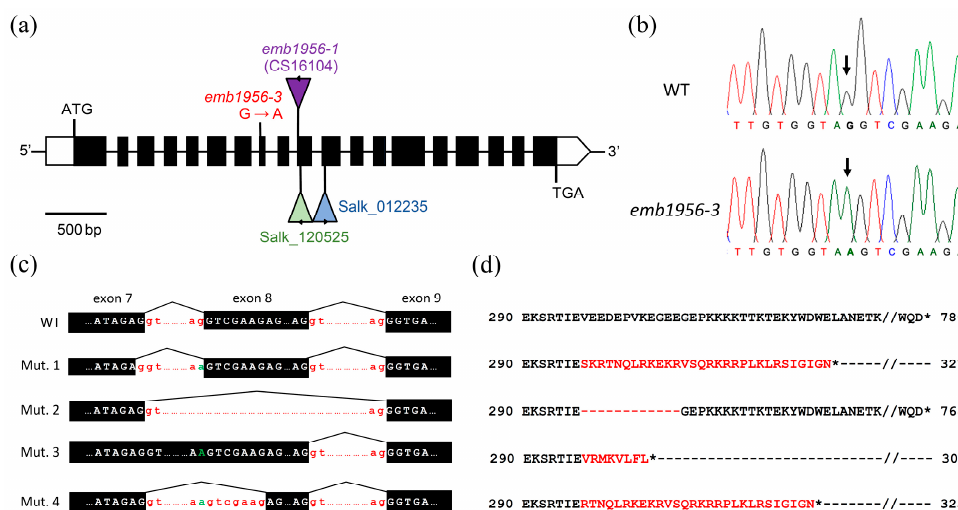
Figure 3. Structure of the At2g04030 gene and effects of the emb1956-3 mutation described in this work. ( a ) Intron–exon structure of the gene. The black rectangles represent the coding sequences. The 5 ′ and 3 ′ untranslated regions (UTRs) are indicated in white. The positions of the insertions and the point mutation are indicated on the scheme. ( b ) G-to-A transition mutation of the emb1956-3 allele (marked by an arrow), as detected via Sanger sequencing. ( c ) The emb1956-3 mutation alters the splicing in four different ways, as detected in the RNA-seq experiments. ( d ) The four splice forms are predicted to alter the sequence of their protein products. Asterisks indicate stop codons.